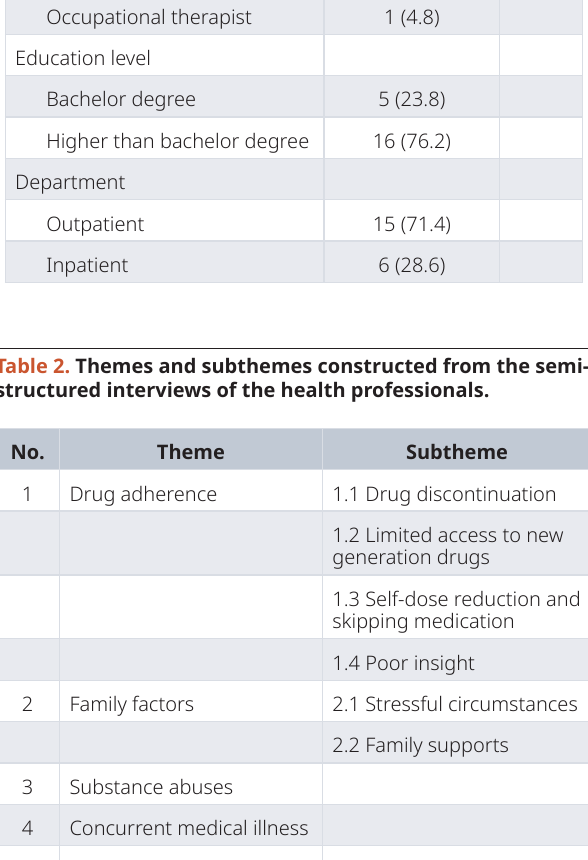
Characteristics